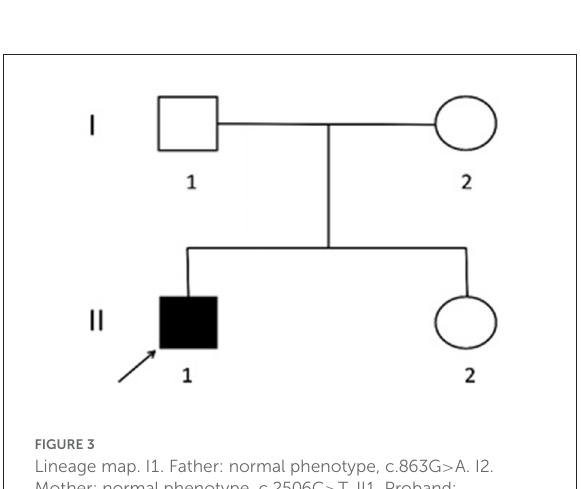
FIGURE3 Lineage map. I1. Father: normal phenotype, c.863G > A. I2. Mother: normal phenotype, c.2506C > T. II1. Proband: hypoglycemia, c.863G > A and c.2506C > T. II2. Sister: normal phenotype and